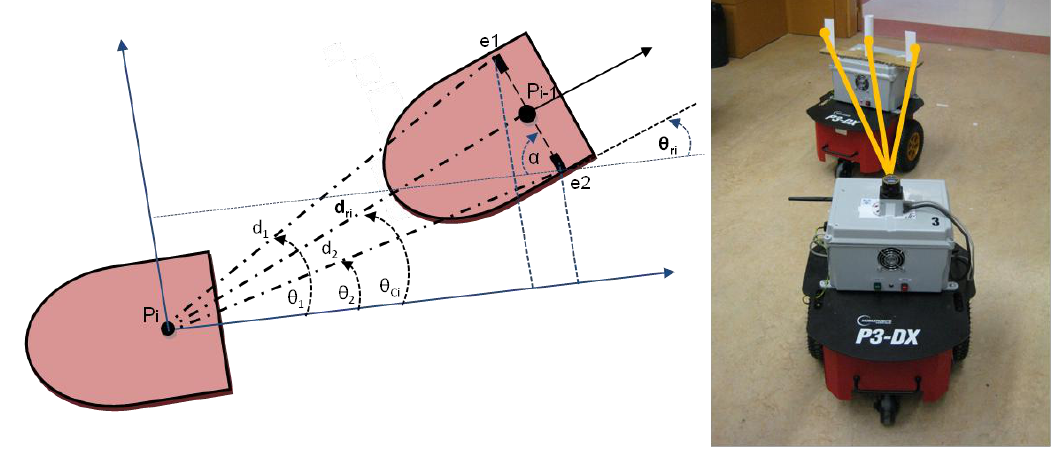
Figure 5. Description of the geometrical relation among the